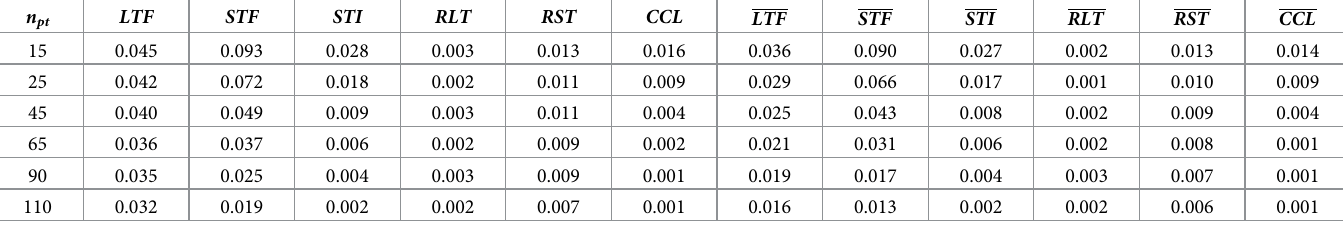
Table 8. Comparison of the average gap AvG for all algorithms according to the number of packets n